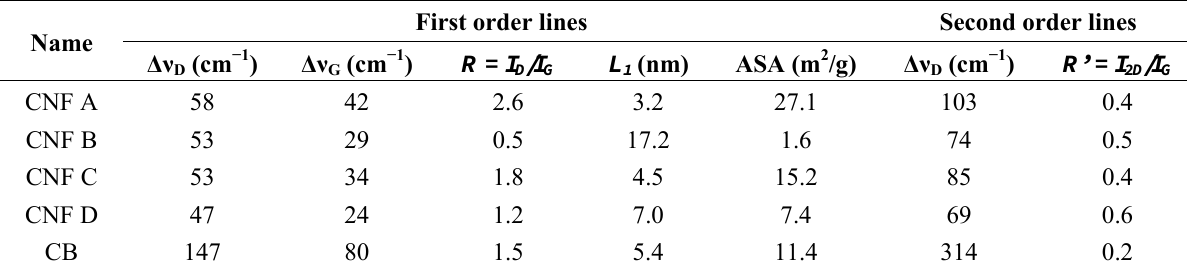
Table 2. Raman data of the CNF powders and CB (equations given in 3.3.3